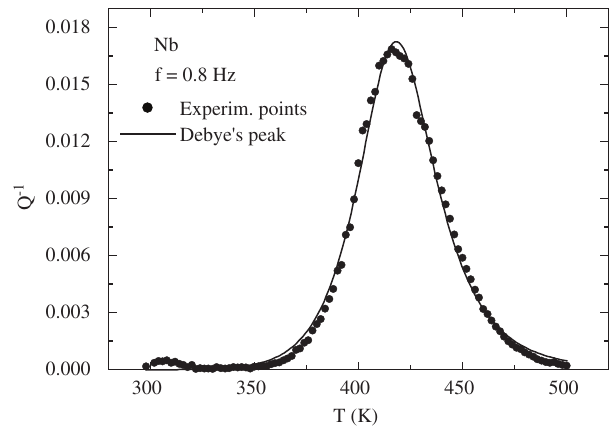
Figure 6. Diffusion coefficient as a function of the inverse of the tempera- ture for Nb-O relaxation process measured with frequencies of 0.80 Hz (•), 1.17 Hz ( ο ), and 4.30 Hz (×).